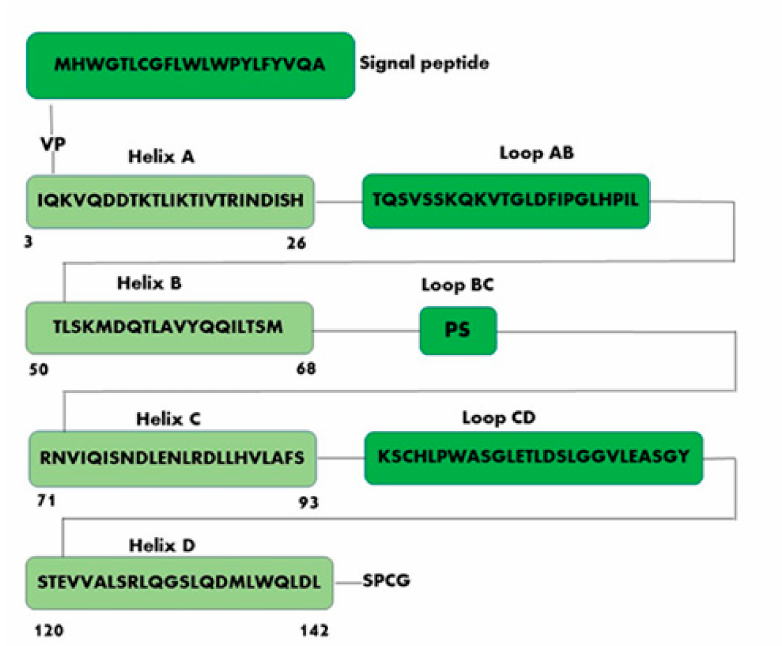
Figure 2. Schematic representation of human leptin sequence. Helix A (amino acid residues 3–26, IQKVQDDTKTLIKTIVTRINDISH); Helix B (amino acid residues 50–68, TLSKMDQT- LAVYQQILTSM); Helix C (amino acid residues 71–93, RNVIQISNDLENLRDLLHVLAFS); Helix D (amino acid residues 120–142,